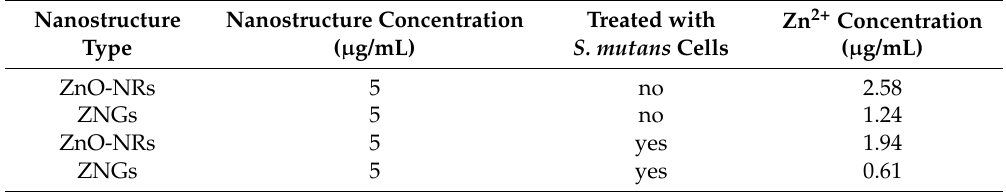
Table 1. Zn 2+ concentration measured by ICP-MS in ZNG and ZnO-NRs suspensions incubated or not with S. mutans for 24